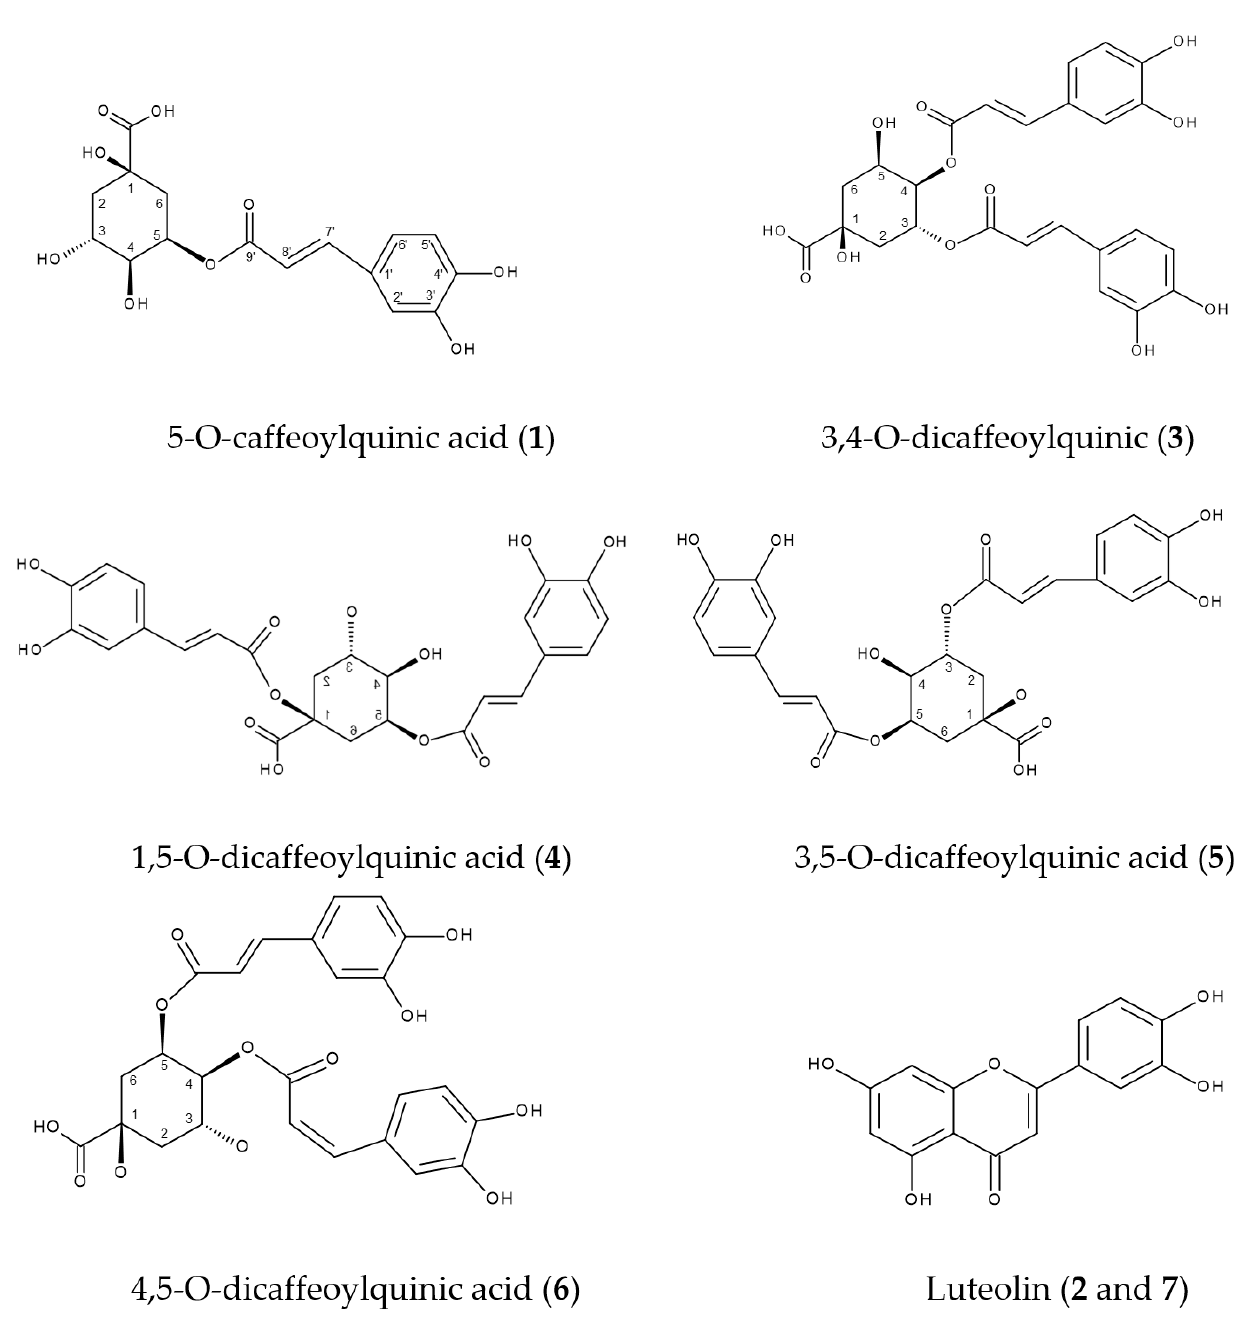
Figure 4. Structures of isolated and quantified compounds in VA.